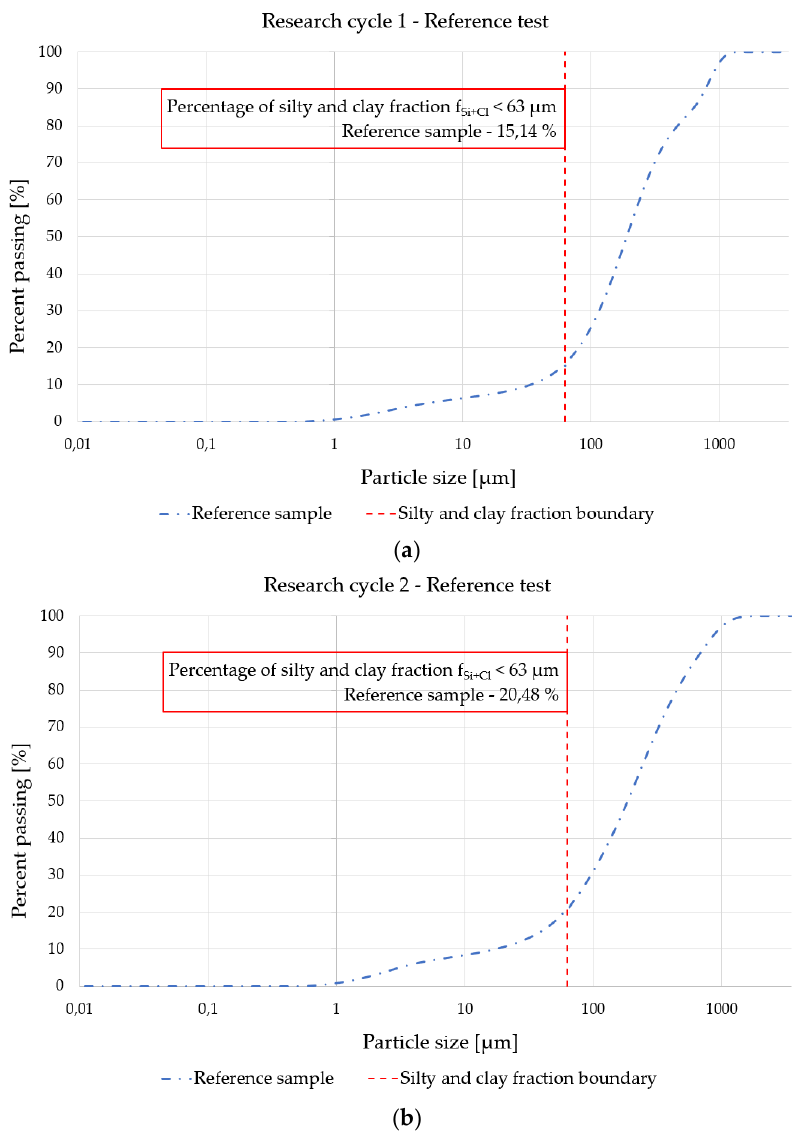
Figure 2. Comparison of graphs of grain size curves for silty sand with silt and clay fractions: ( a ) f Si+Cl ,1 = 15.14% and ( b ) f Si+Cl ,2 = 20.48%.